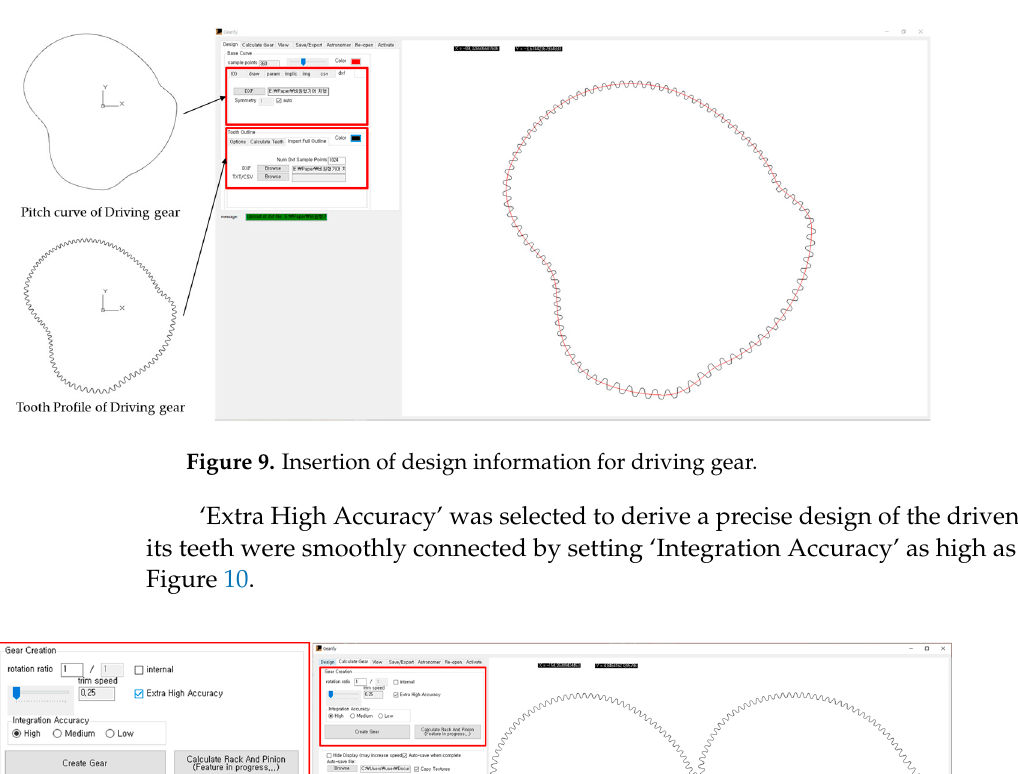
Figure 10. Setting of driven gear for precise design.